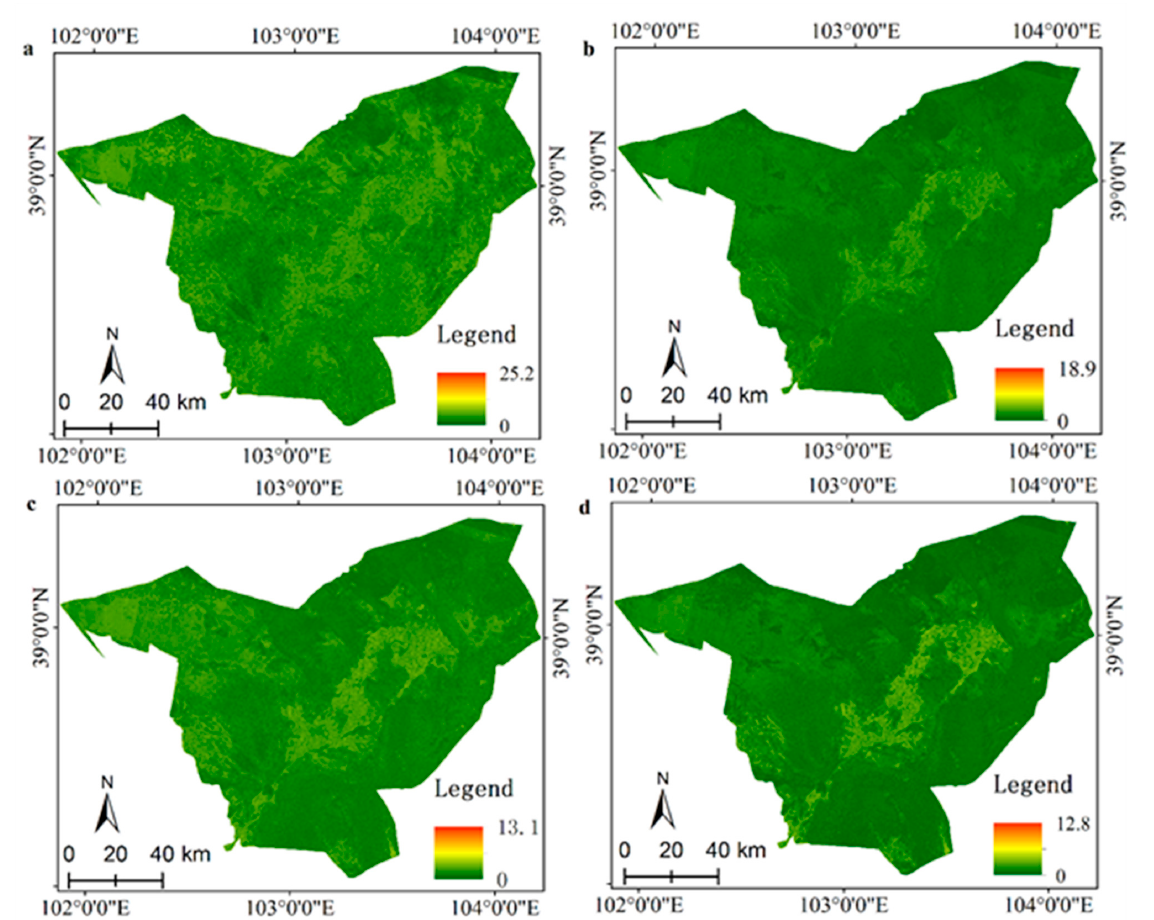
Figure 7. Spatially continuous mapping uncertainty (g·kg − 1 ) of the XWT-based framework for ( a ) RR, ( b ) LS-SVM, ( c ) RF, and ( d ) GBRT. We used 1.645 times the standard deviation derived from 20 repetitions of SOM mapping results as the threshold for evaluating mapping uncertainty at a 90% prediction interval.